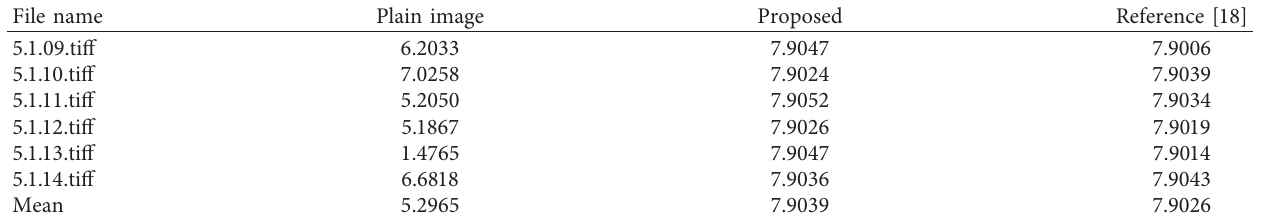
Table 4: Local Shannon entropy (LSE)